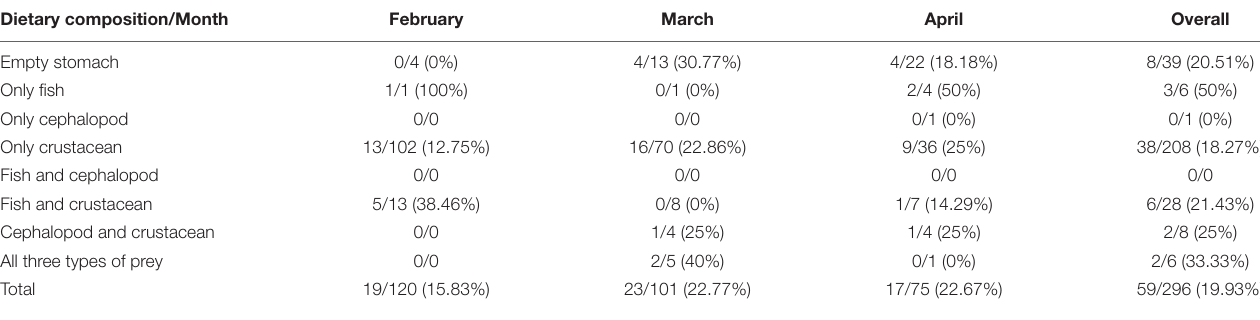
TABLE 5 | Comparison of dietary compositions and artifact ingestion of the Argentine shortfin squid Illex argentinus sampled in this study, shown as the number of stomachs with artifact ingestion/number of total stomachs, including empty and non-empty, and the calculated percentages are shown in parentheses. Dietary